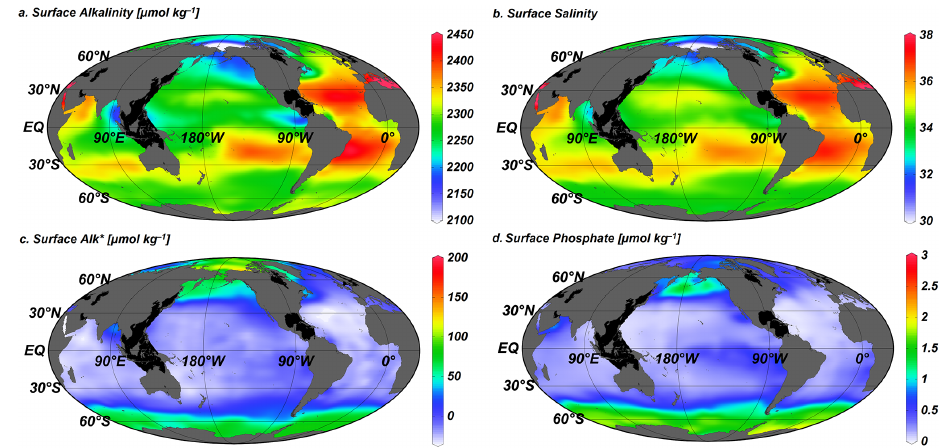
Figure 2. Global (a) total alkalinity A T , (b) salinity, (c) Alk ∗ , and (d) phosphate distributions at the surface (10m depth surface) from our gridded CARINA, PACIFICA, and GLODAP bottle data product detailed in Supplement document SA. Areas with exceptionally poor coverage in the data used to produce the gridded product are blacked out.